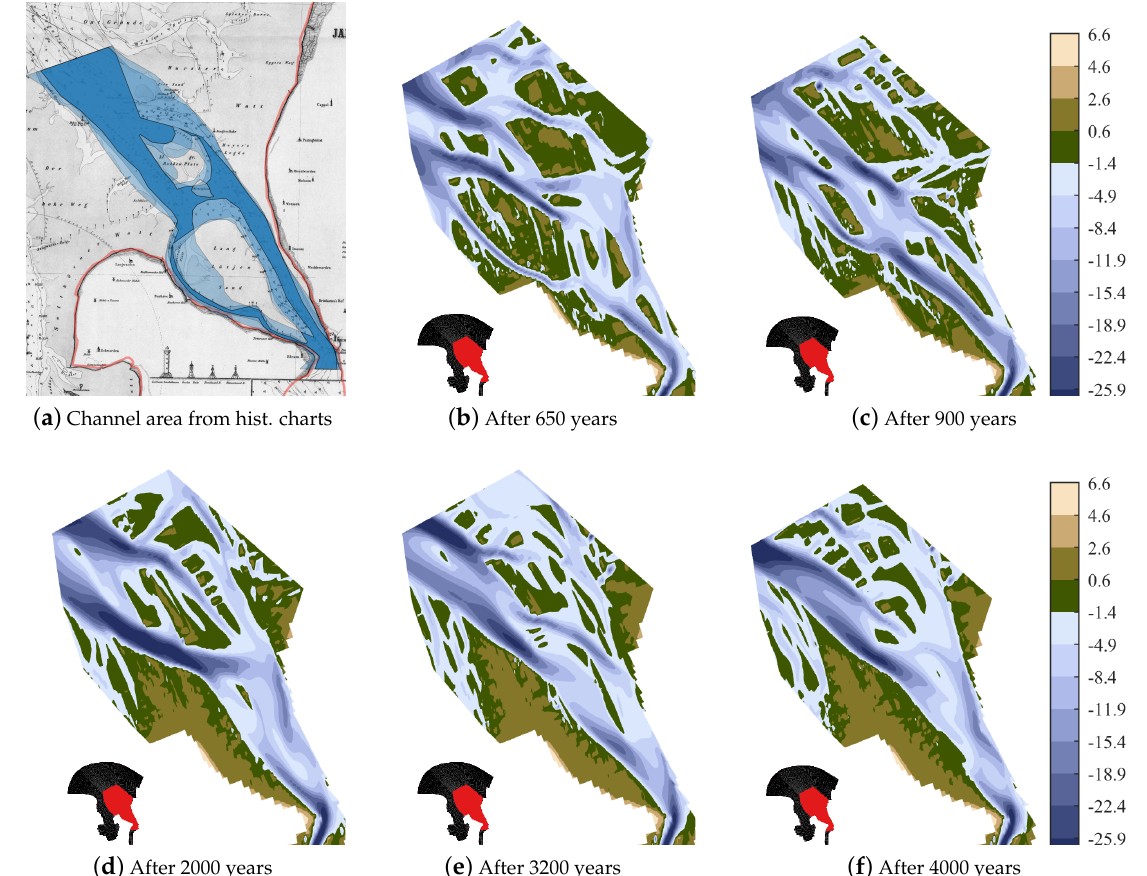
Figure 5. Simulation results of the base case. In ( a ), the locations of the tidal channel system from three historical charts (1812, 1859, 1870) are intersected. In ( b – f ), results of the morphological simulations are shown for different years, with channel depths in blue and shoals in earth